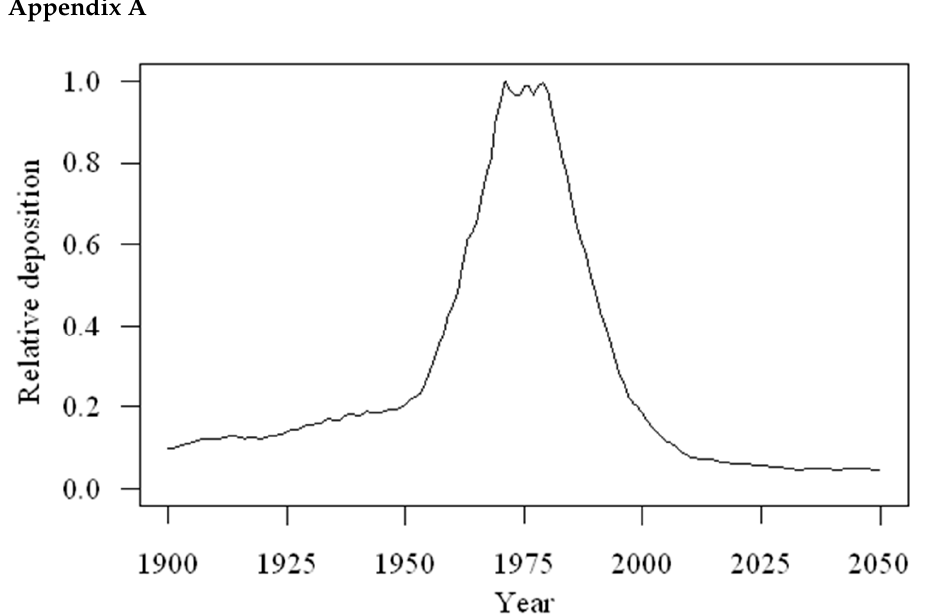
Figure A1. Standard curve for non-marine deposition in Lower Saxony, Germany. Adapted from Engardt et al. [9].